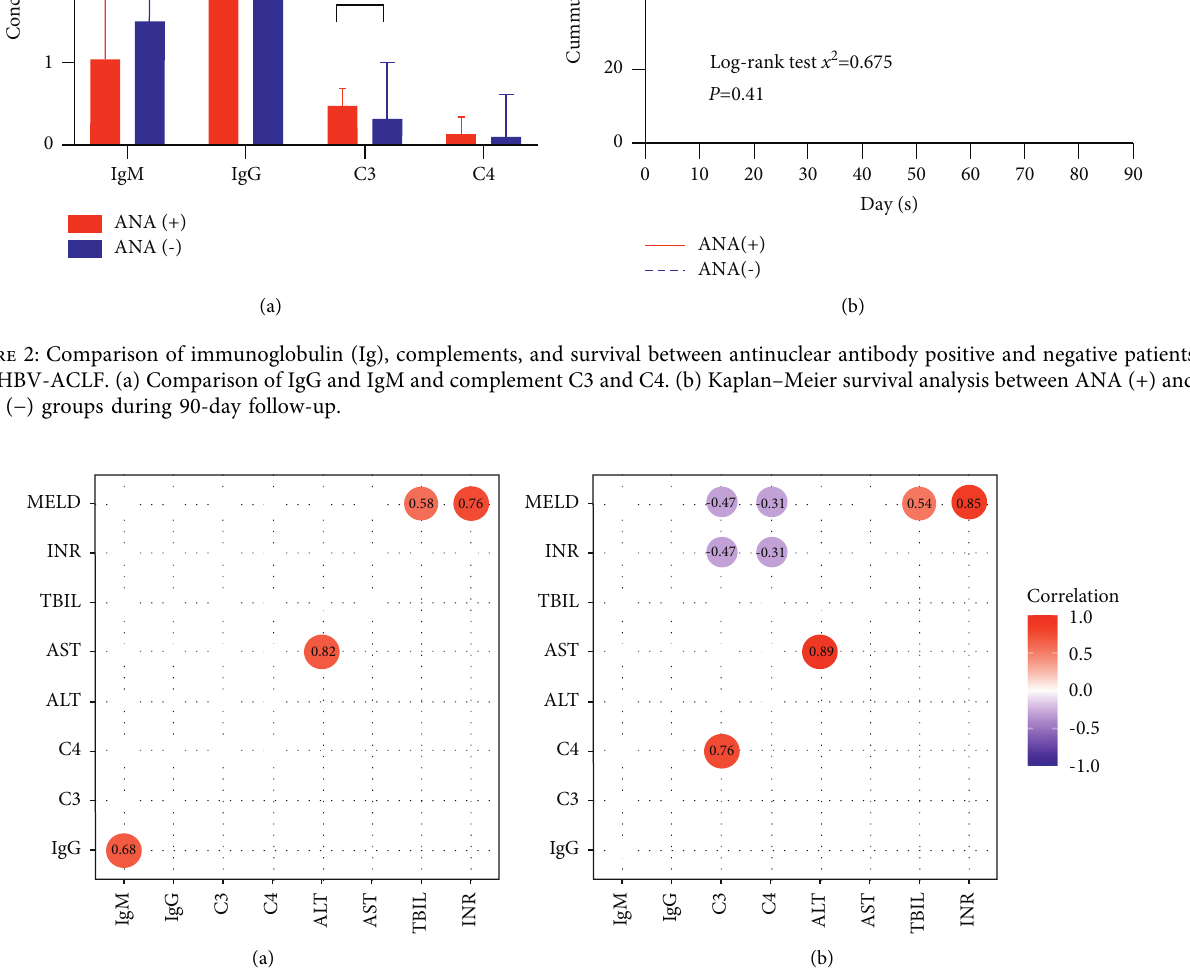
Figure 3: Correlation analysis between immunoglobulin (Ig), complement (C), and model for end-stage liver disease